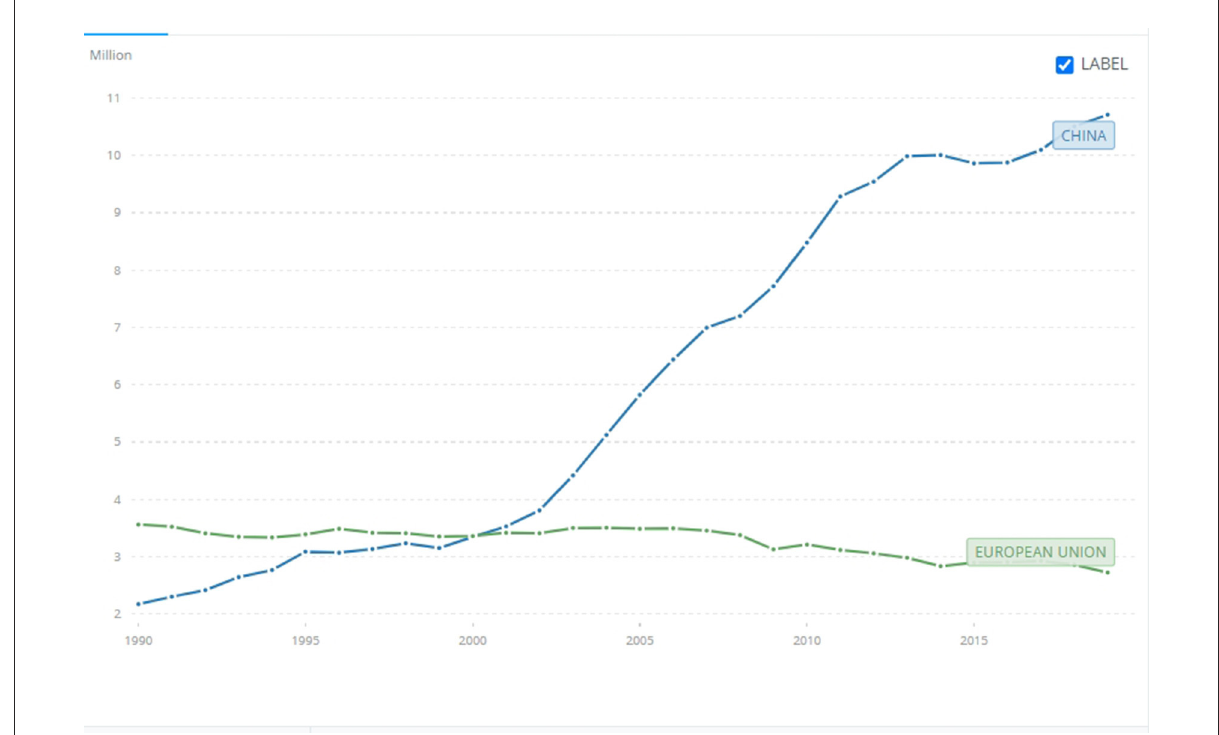
FIGURE5 CO2 emissions. China and EU28 in comparison. Timeframe: 1990-2019. Source World Bank: https://data.worldbank.org/indicator/EN.ATM. CO2E.KT?contextual=default&end=2019&locations=CN-EU&most_recent_year_desc=false&start=1990&view=chart (accessed August 9,